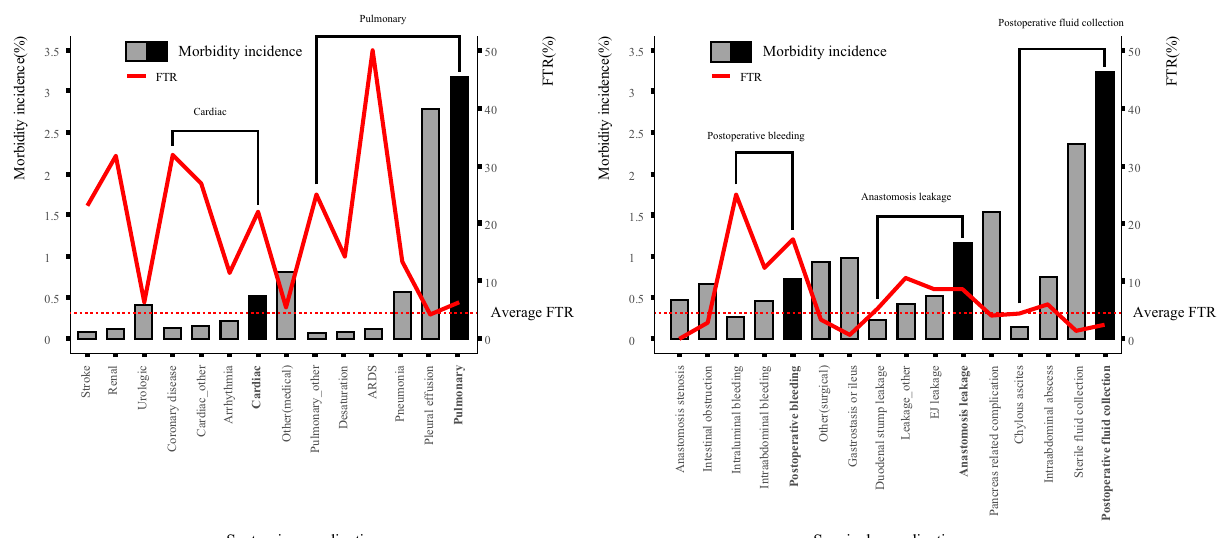
Figure 3. Incidence of morbidity and failure-to-rescue (FTR) rate according to complication types (the height of the gray or black box indicates the morbidity incidence and is displayed on the left y-axis. The red line indicates the FTR rate and is displayed on the right